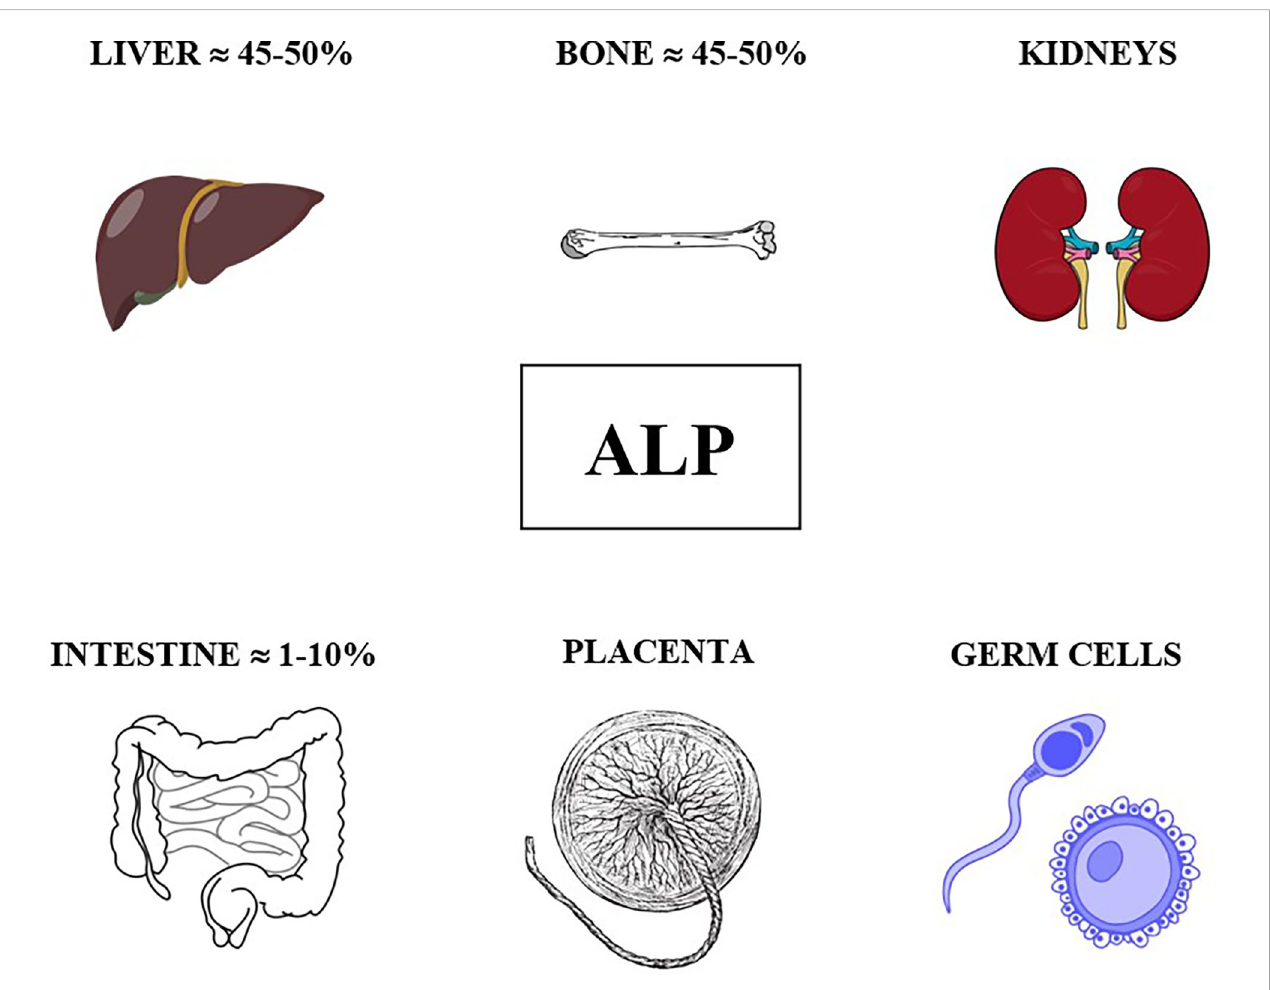
FIGURE 1 ALP isoenzymes and their circulating levels in healthy